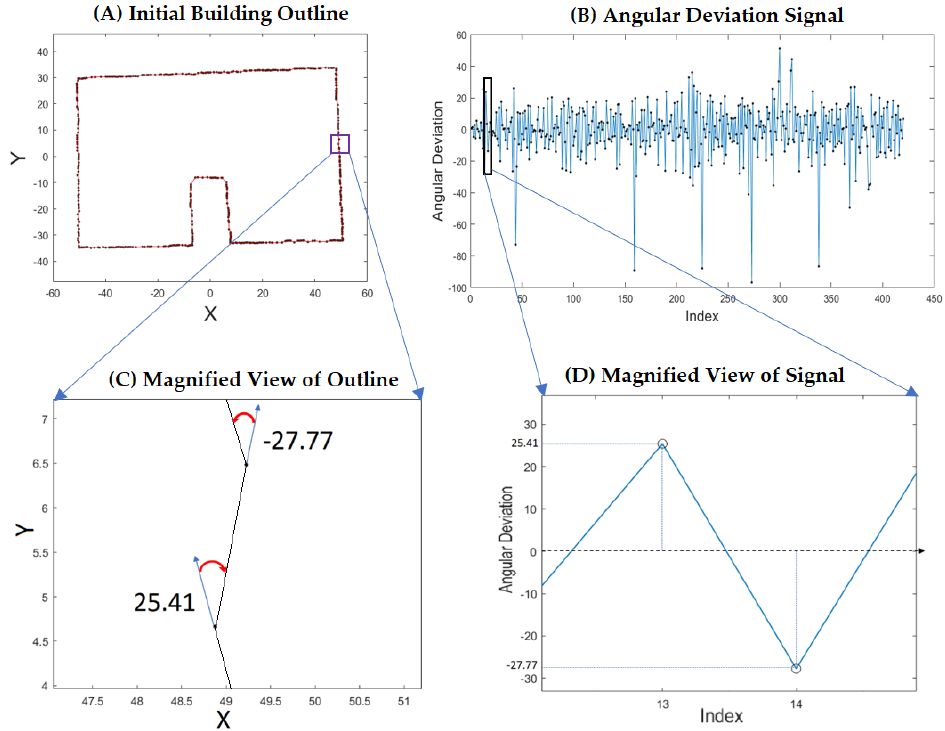
Figure 5. Transforming the initial building outline to discrete signal. ( A ) The initial outline of a building; ( B ) The entire plot of the transformed signal; ( C ) The magnified view of angular deviations at vertex number 13 and number 14; ( D ) The magnified view of the signal plot when index equals to 13 and 14.